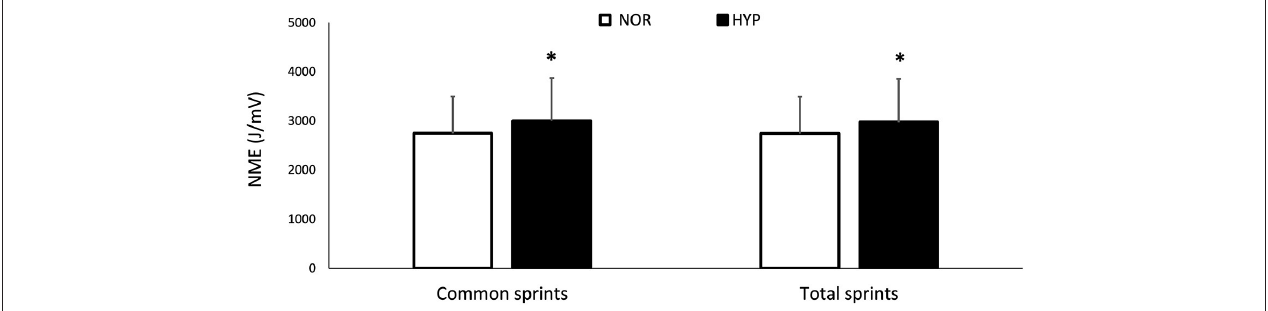
FIGURE 3 | Changes for neuromuscular efficiency (NME) over the entire series of sprints (NME tot ) and for the same number of sprints performed in both conditions (NME com ) over the repeated-sprint ability test in normoxia and hyperoxia (F I O 2 0.40). Data are presented as means ± SD. *Small effect between conditions. NME tot values were 2747.12 ± 746.54AU in NOR and 2975.51 ± 879.80AU in HYP. NME com values were 2749.86 ± 746.07AU in NOR and 3000.14 ± 872.70AU in